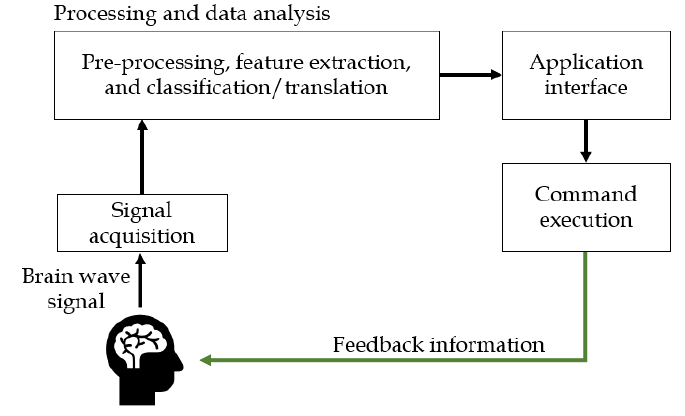
Figure 7. The components and flow diagram of a Brain–Computer Interface (BCI) system, adapted from